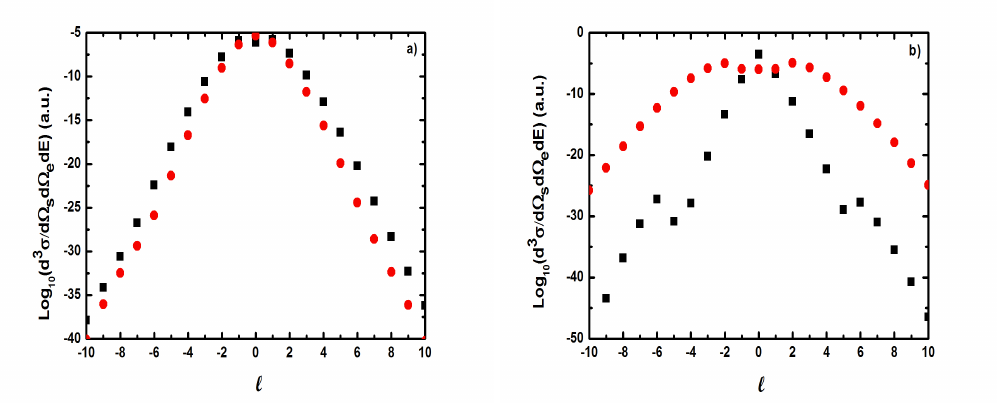
Figure 23. First Born triple differential cross sections corresponding to laser-assisted electron-impact ionization of atomic hydrogen in the ground state for the case of a coplanar symmetric geometry as a function of the number of photons exchanged (cid:96) . The scattering angle is ( a ) θ = 10 ◦ and ( b ) θ = 30 ◦ . = 250 eV, the laser frequency is ω = 1.17 eV and the electric field The incident electron energy is E k i strength is E 0 = 10 7 V/cm. Squares: the laser polarization vector is taken to be parallel to the incident momentum. Circles: the laser polarization vector is taken to be perpendicular to the incident